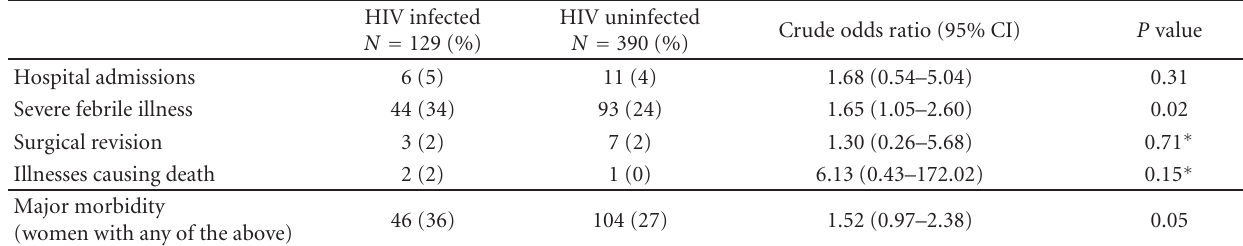
Table 2: Major morbidity in HIV-infected and uninfected women by 6 weeks after